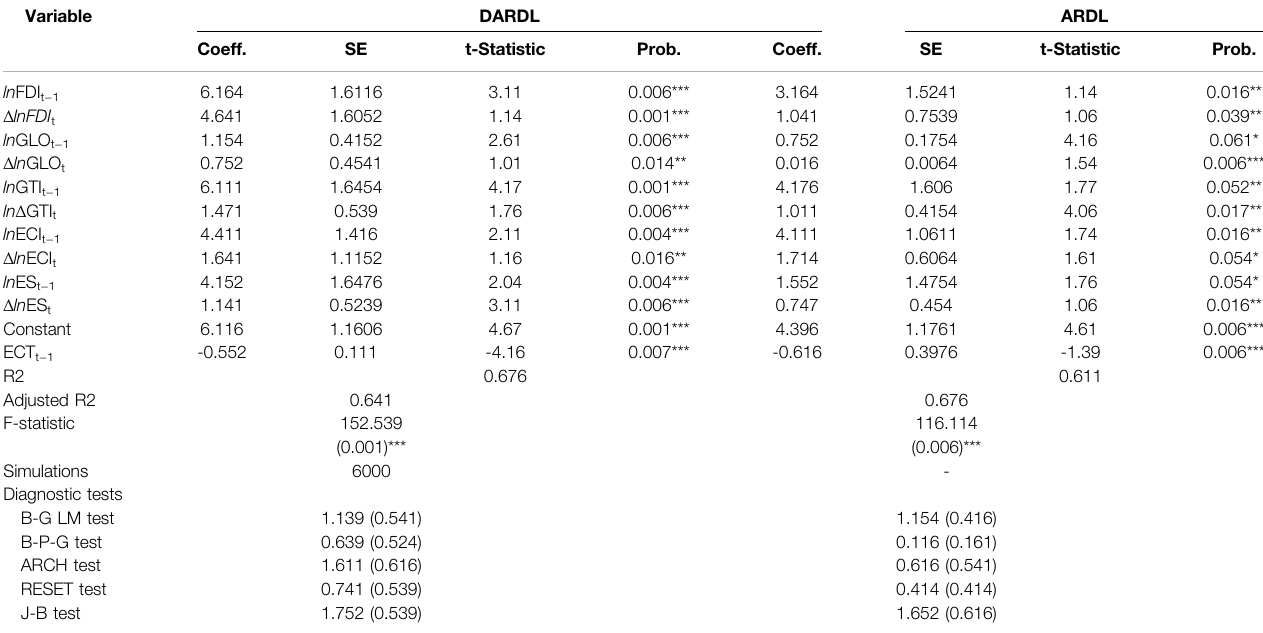
TABLE 7 | DARDL and ARDL estimation results. Variable DARDL ARDL Coeff. SE t-Statistic Prob. Coeff.